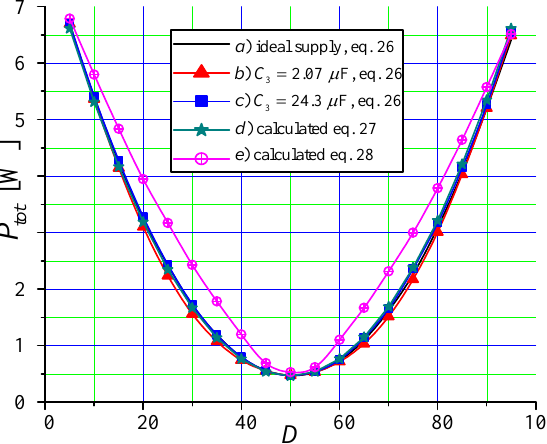
Figure 10. Measured and calculated power consumption: ( a ) measured, bilateral power supply; ( b ) measured, unidirectional supply and C 3 = 2.07 µ F; ( c ) measured, unidirectional supply and C 3 = 24.3 µ F; ( d ) calculated, ideal case augmented with quiescent consumption P 0 ( e ) calculated, unilateral power supply and perfect absorption of negative supply currents, raised with quiescent consumption P 0 (ideal dissipative method) .